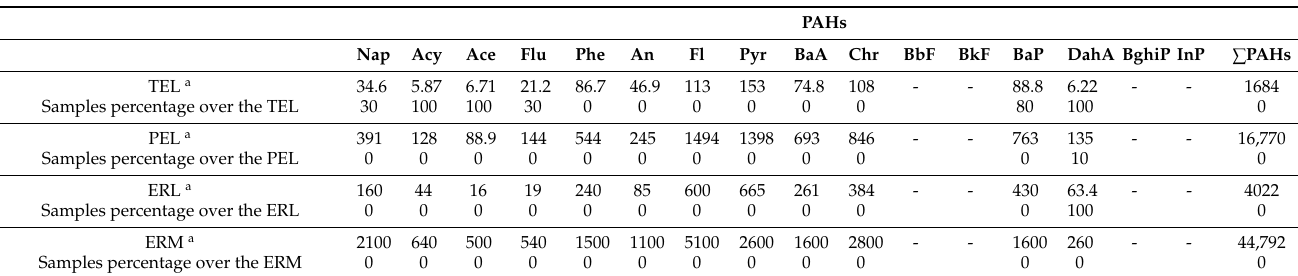
Table 4. A comparison of the threshold effect level (TEL), probable effect level (PEL), effect range low (ERL), and effect range median (ERM) guideline values ( µ g kg − 1 ) for polycyclic aromatic hydrocarbons and data found in the Volturno River, Southern